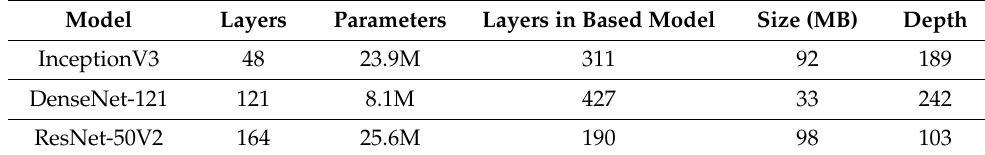
Table 4. Models and their